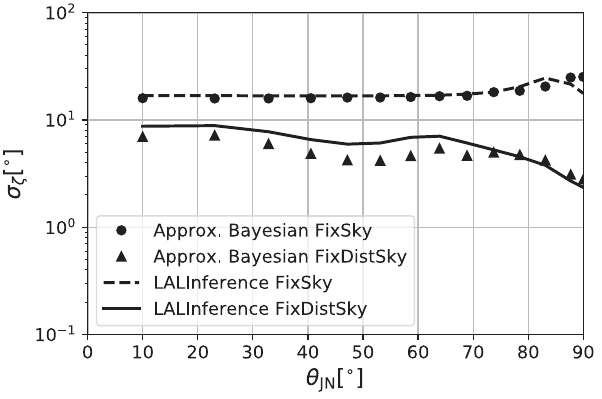
FIG. 4. Standard deviation for the viewing angle of source D against the true value of the inclination angle as measured with the full LALI NFERENCE code (lines) and with the approximate Bayesian estimator (symbols). Triangles correspond to the case when both the distance and sky position are known, while circles assume that only the sky position is